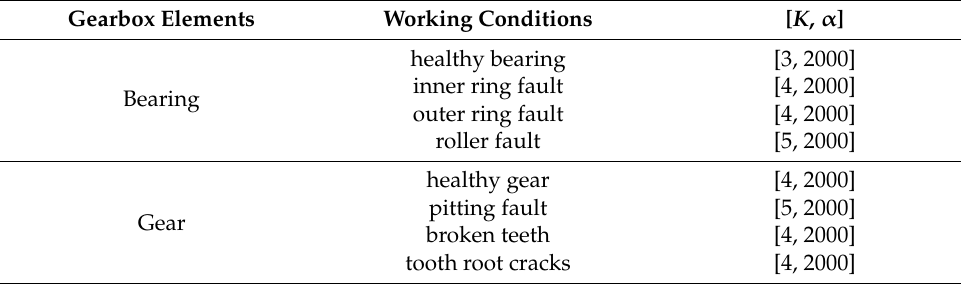
Table 12. Values of [ K α ] for VMD in the eight working conditions.